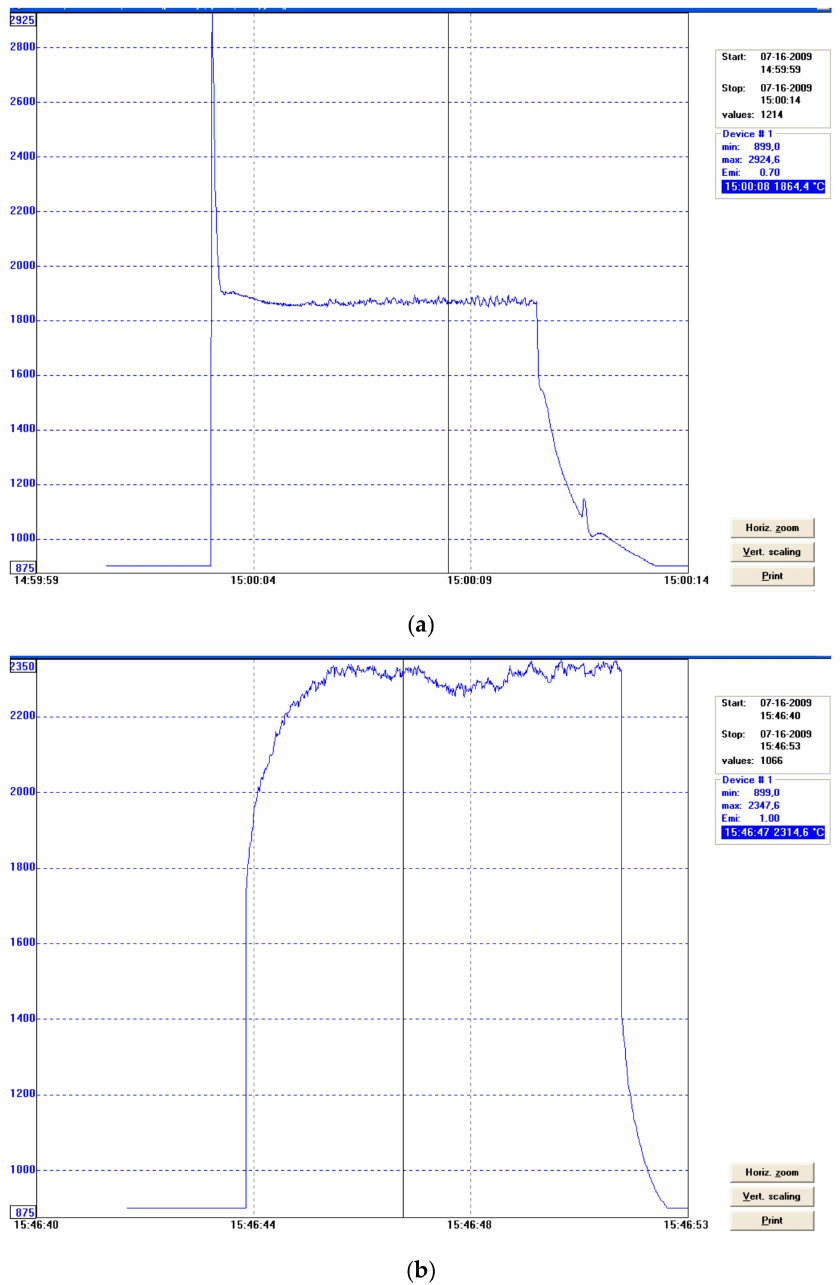
Figure 12. Results of temperature measurements on the surface of the melt pool during laser melting titanium alloy Ti6Al4V by HPDDL at output power of 1210 W and scanning speed 200 mm / min (200 mm / min): ( a ) in argon atmosphere, chosen value of emissivity ε = 0.7, mean temperature 1870 ◦ C; ( b ) in nitrogen atmosphere, chosen value of emissivity ε = 1.0, mean temperature 2200 ◦